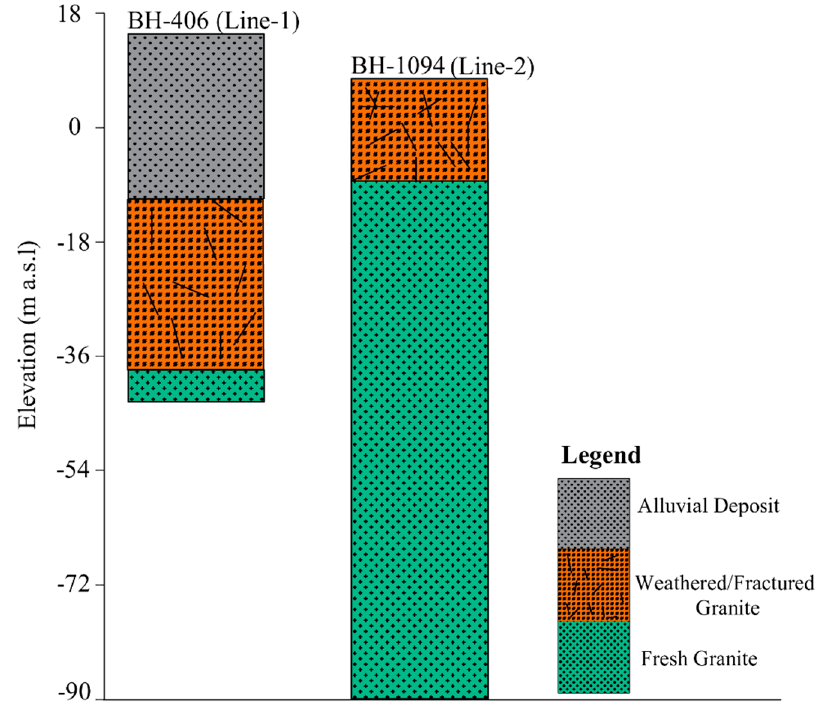
Figure 2. Geology of the subsurface layers from well log data. a.s.l. = above sea level.